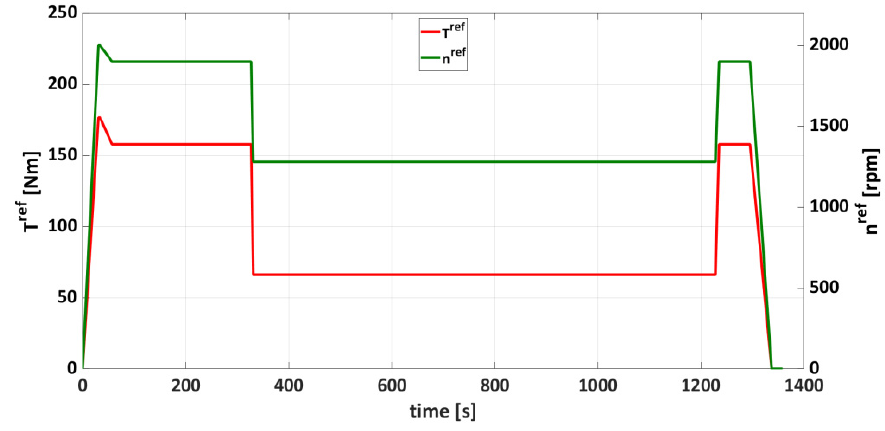
Figure 1. Propeller torque T ref and rotational speed n ref profile for stationary tests of electric drive.